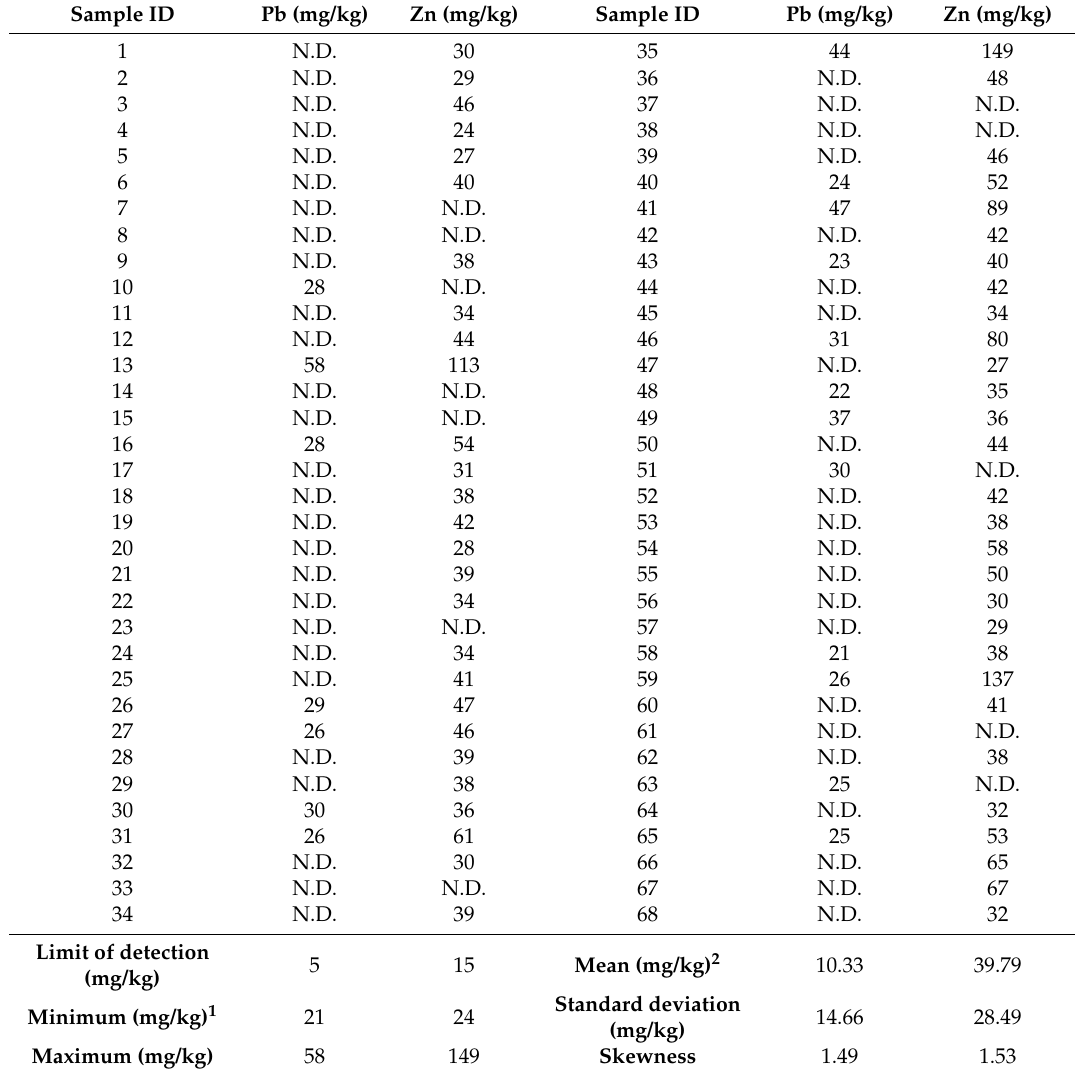
Table 1. The portable X-ray fluorescence (PXRF) results of the Pb and Zn concentrations of each sample.